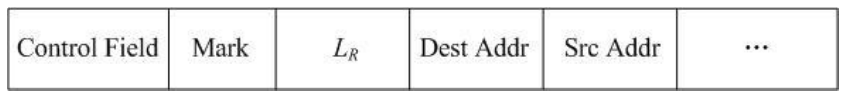
Figure 2. The structure of the data